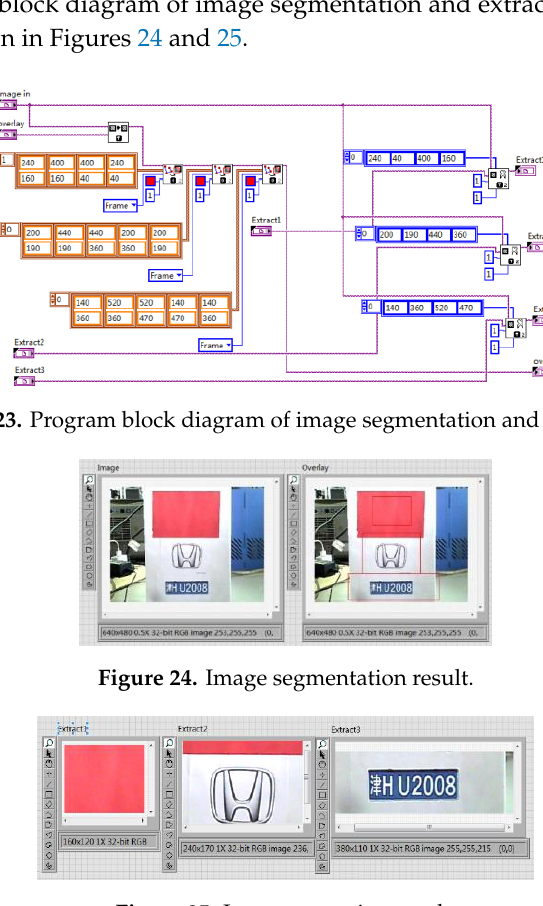
Figure 25. Image extraction result.